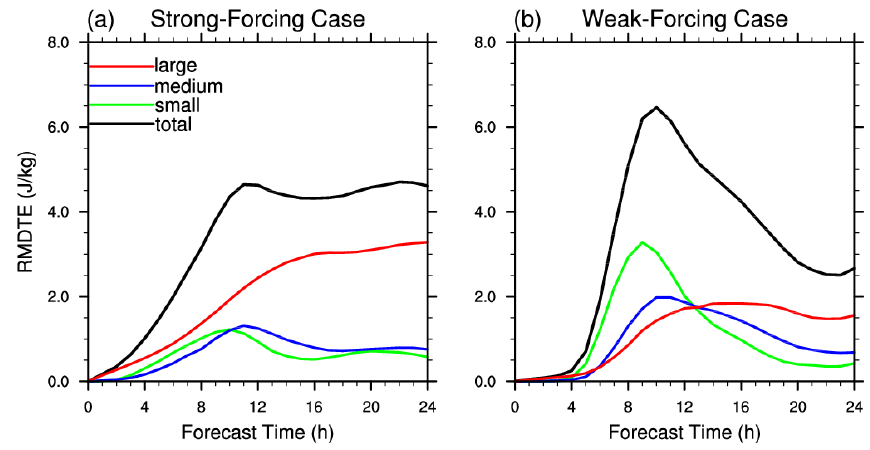
Figure 8. Temporal evolution of the RMDTE in the ( a ) SF case and ( b ) WF case at various scales (black line: total RMDTE; red line: large-scale RMDTE; blue line: medium-scale RMDTE; green line: small-scale RMDTE).